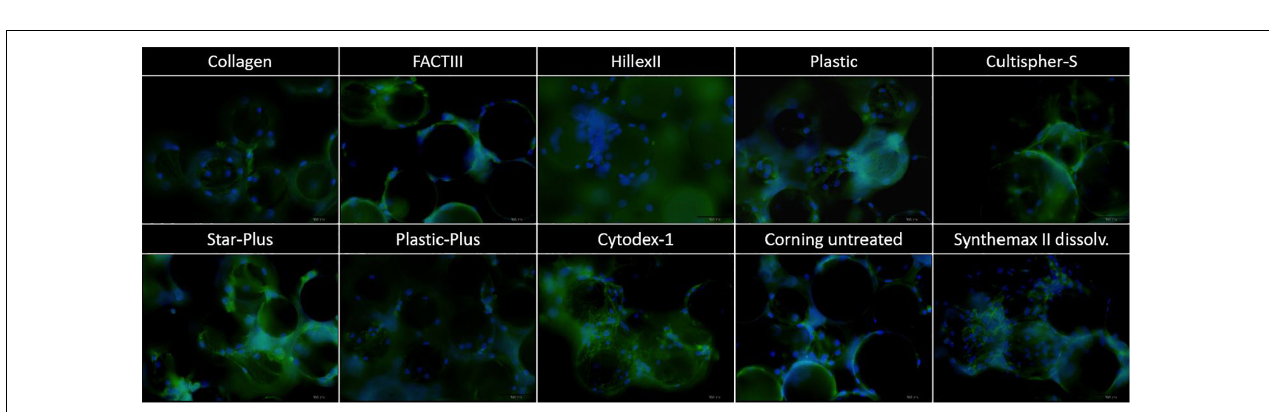
FIGURE 2 | Live dead imaging of the microcarriers Collagen, FACTIII, HillexII, Plastic, Star-Plus, Plastic-Plus, Cytodex-1, and Corning untreated. The figures in row 1 and 3 represent the live-dead stainings, where live cells are stained green and dead cells are stained red. The figures in row 2 and 4 represent the merged images of bright field images combined with the live dead stainings to visualize the cells with respect to the microcarriers.